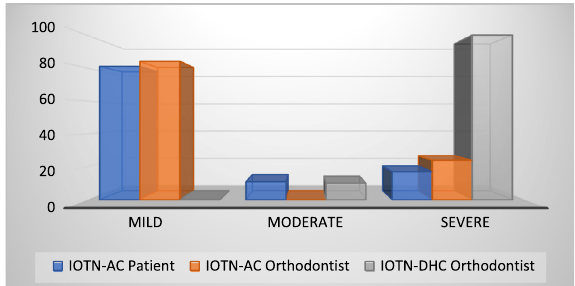
Figure 4. Frequency of scores for patient IOTN-AC and orthodontist IOTN-AC and